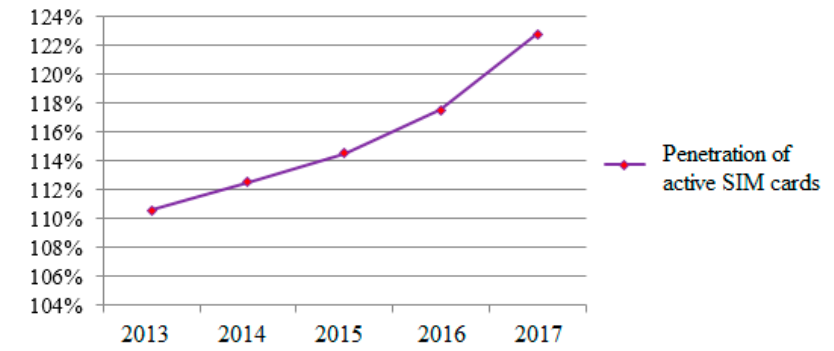
Figure 2. Development of active SIM cards penetration.